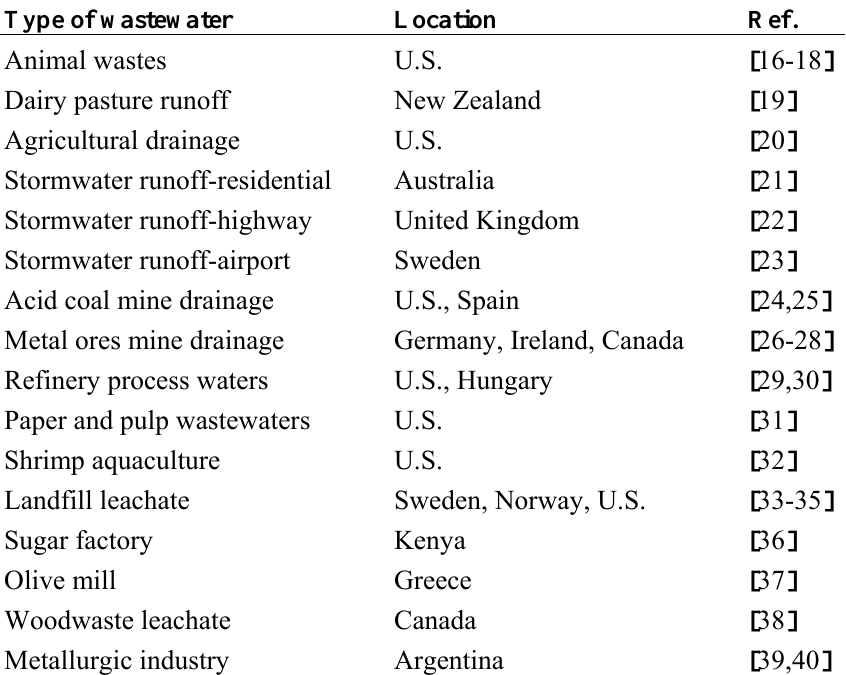
Table 1. Examples of the use of FWS CWs for various types of wastewater.